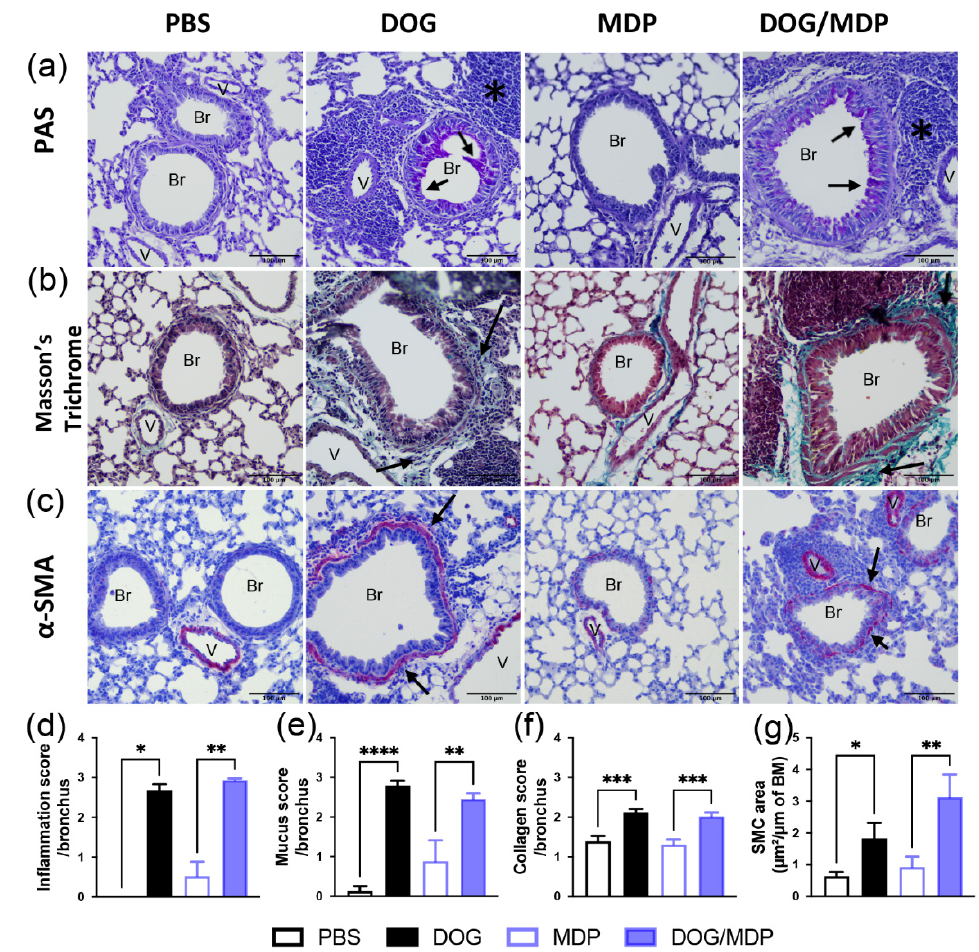
Figure 5. Dog-allergen-induced AAI is associated with bronchial remodeling without additional effect of MDP. Representative microphotographs and quantification of stained paraffin-embedded lung sections for ( a ) inflammation and mucus production using PAS (pink color), ( b ) collagen using Masson’s trichrome (blue/green staining), and ( c ) immunohistochemistry staining of SMC using α -smooth muscle actin (SMA) antibody (positive cells are stained in red). Scale bars: 100 µ m. Black arrows show staining of interest (mucus, collagen, and SMC), and black stars show inflam ‐ mation. V: vessel, Br: bronchus. Quantification of lung sections for ( d ) inflammation, ( e ) mucus, ( f ) collagen, and ( g ) SMC staining. Data are presented as mean ± SEM (n = 4–7 mice per group, with 3 to 9 different lung sections analyzed). * p < 0.05, ** p < 0.01, *** p < 0.001, **** p < 0.0001 versus PBS or MDP. Kruskal–Wallis test for all, except for figures ( e ) and ( f ), which are 1 ‐ way ANOVA. 2.4. NOD2 Ligand and Allergen Co ‐ Administration Does Not Change the Formation of iBALT in Mice The mouse model of dog ‐ allergen ‐ induced AAI leads to the formation of tertiary lymphoid organs, i.e., iBALT, composed of B, T cells, germinal centers with follicular dendritic cells (FDC) [34], and high endothelial venules allowing lymphocyte entry from the blood. Although the presence of iBALT has been observed in bronchial biopsies from asthmatic patients [35], the protective or deleterious role of these follicles in asthma is not clearly defined [36]. To ensure that the NOD2 ligand did not modify the formation of these follicles after co ‐ administration with dog allergen, histopathological examination of the lung tissue was performed. Mice sensitized with dog allergen with or without MDP developed peribronchial ectopic follicles similar in number and size (Figure 6a). The formation of iBALTs is characterized by antibody production, so we next assessed local Ig production. BAL total IgA and dog ‐ allergen ‐ specific IgG1 were strongly increased in